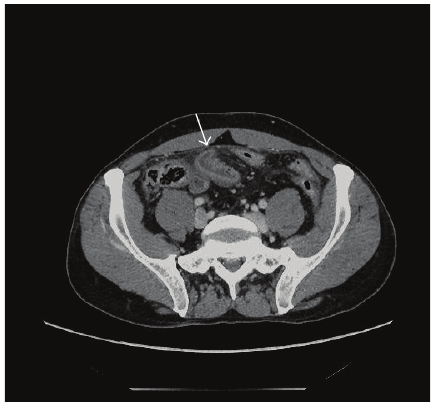
Figure 1: Contrast enhanced axial CT of the abdomen in a 45- year-old male with an inguinal trauma. Bowel wall thickening and enhancement.